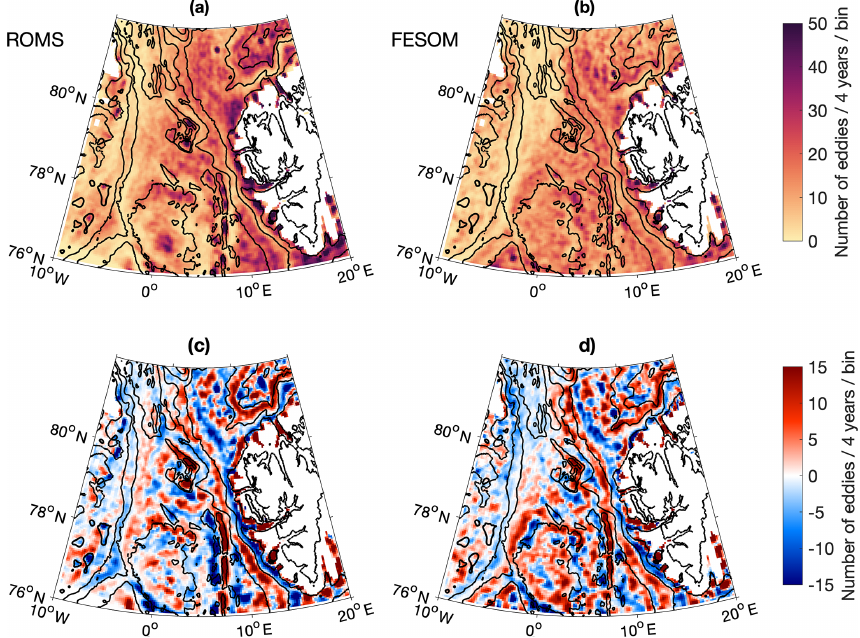
Figure 6. (a, b) Total number of eddy occurrences in the years 2006–2009 for (a) ROMS and (b) FESOM, binned in a 1 / 24 ◦ grid and smoothed with a three-point Hanning window kernel. (c, d) Difference between numbers of cyclonic and anticyclonic eddies (cyclones minus anticyclones). Black contour lines indicate bathymetry at 1000m intervals and at 200m.